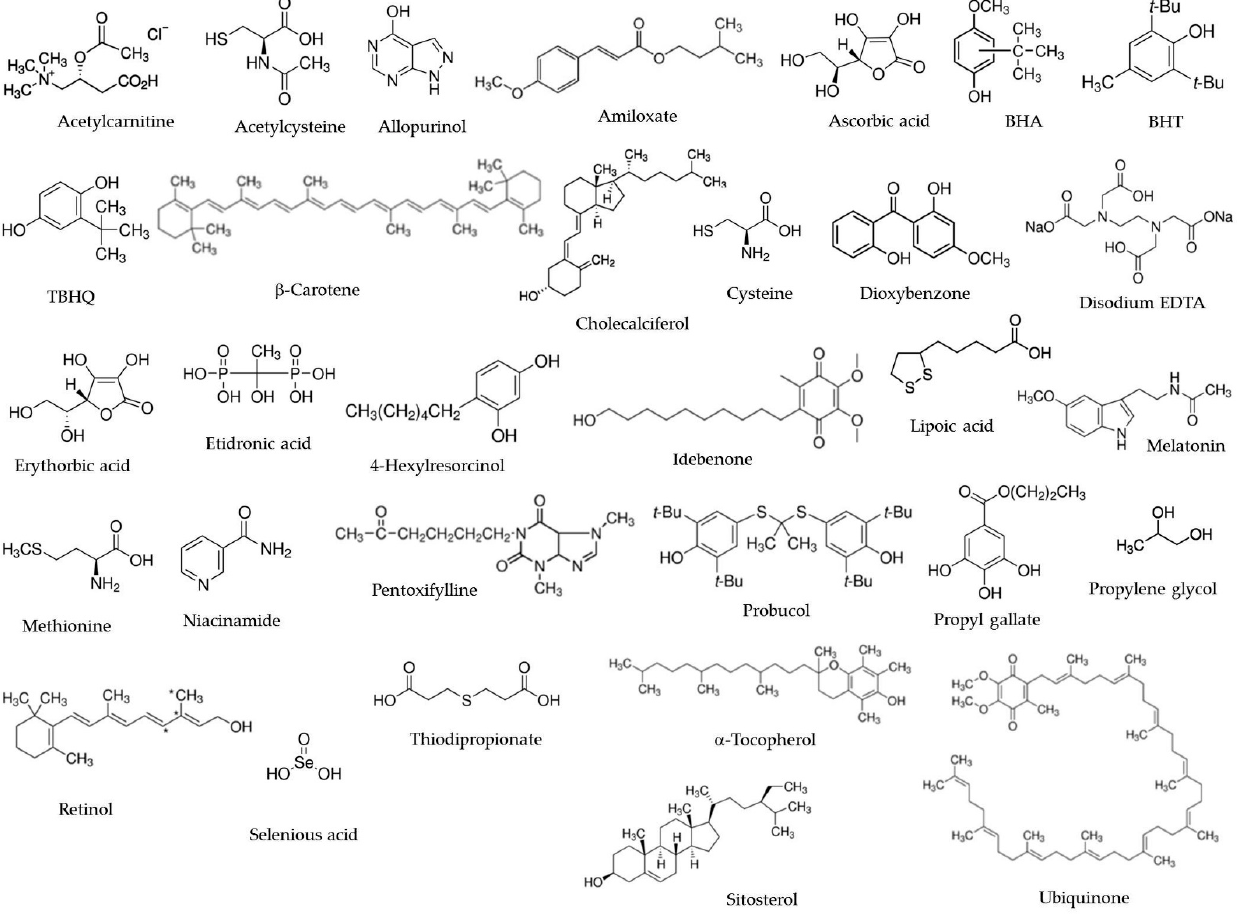
Figure 2. Chemical structure of approved principal synthetic low-molecular-weight antioxidants (alphabetical